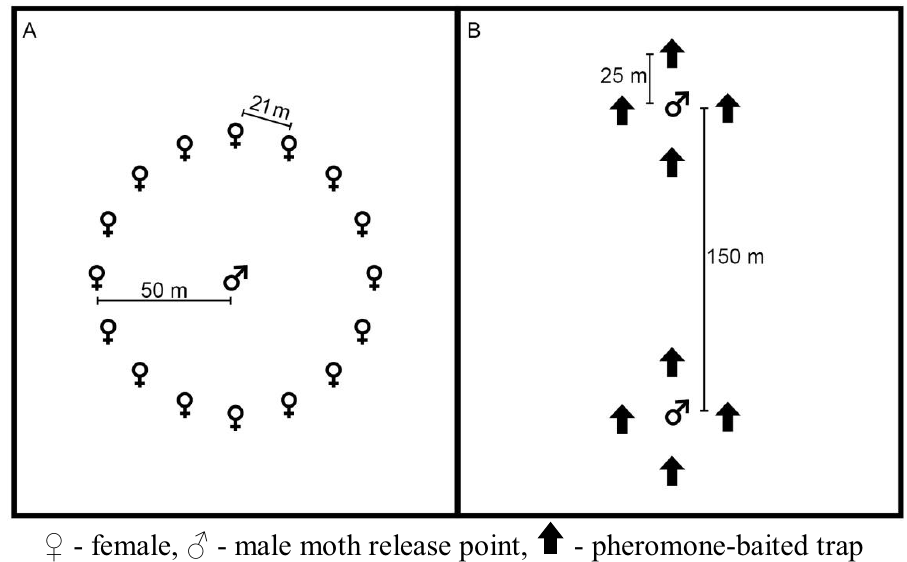
Figure 1. Generalized plot layout for the short- and long-term pheromone persistence ( A ) and pheromone persistence between two climate regimes ( B )